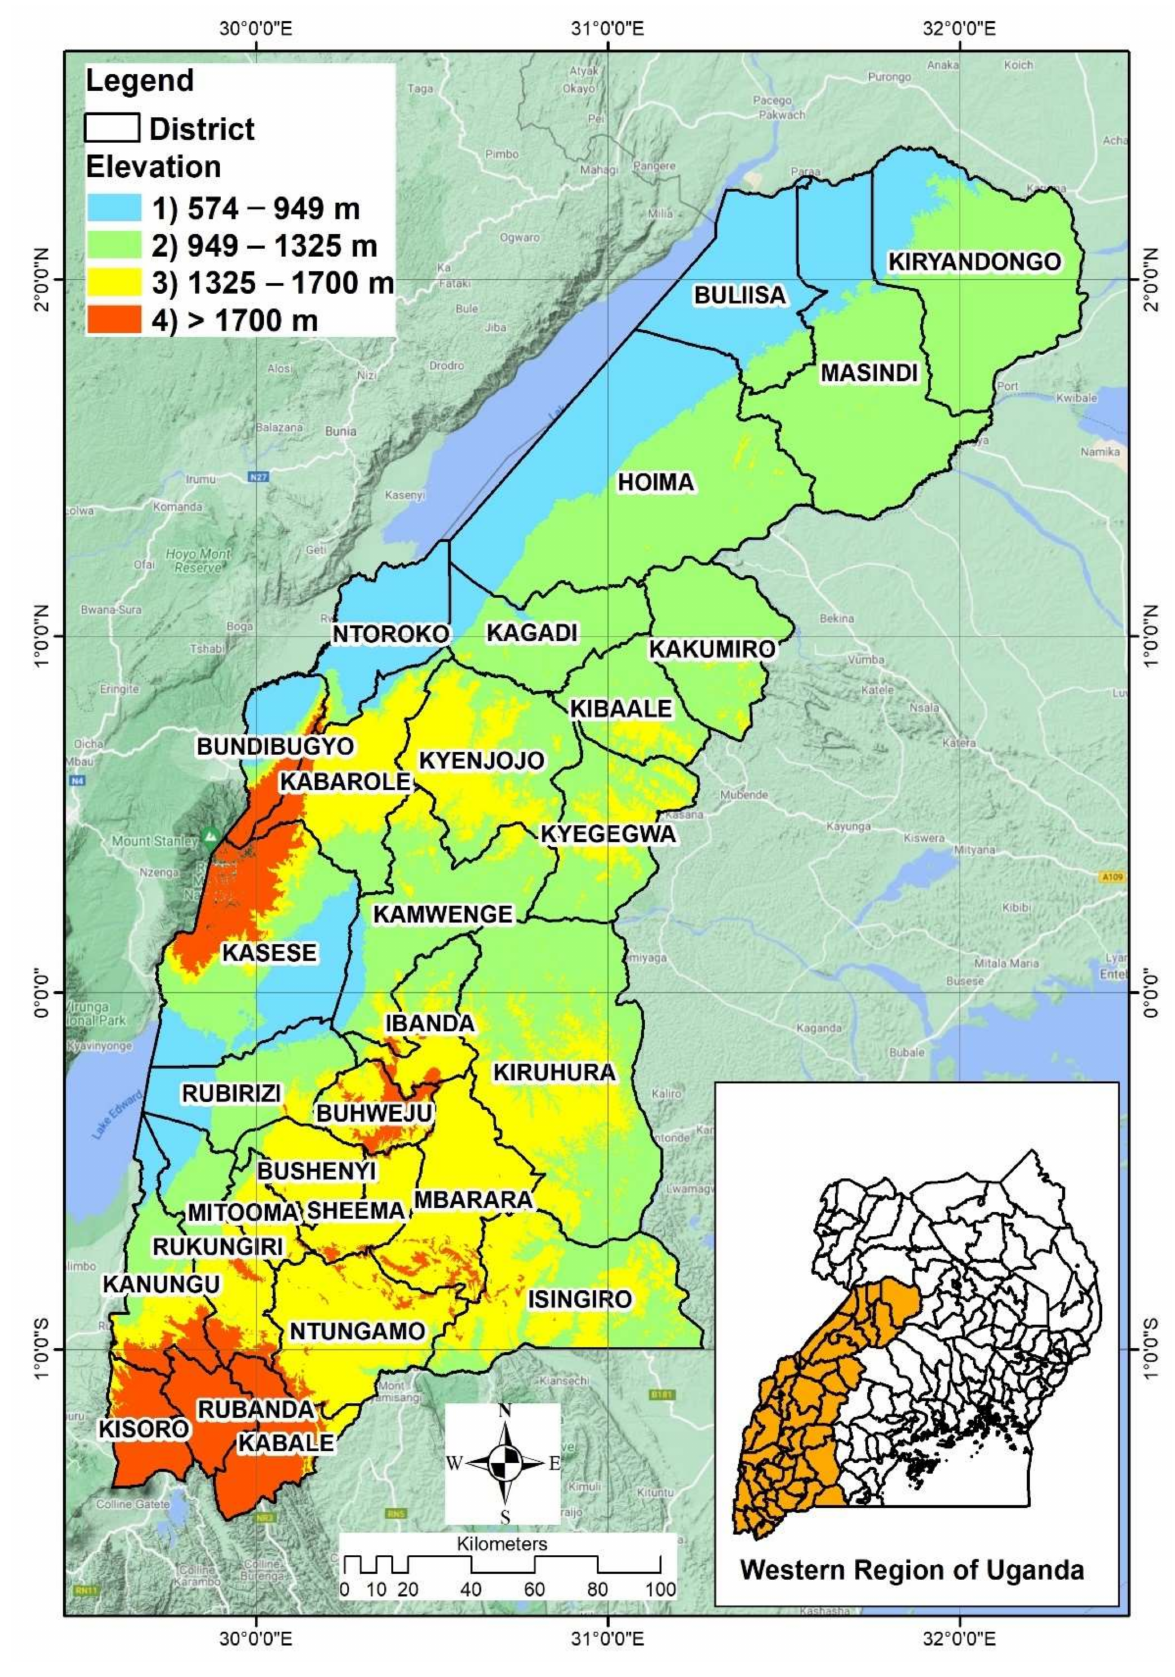
Figure 4. Suitability map of study area by